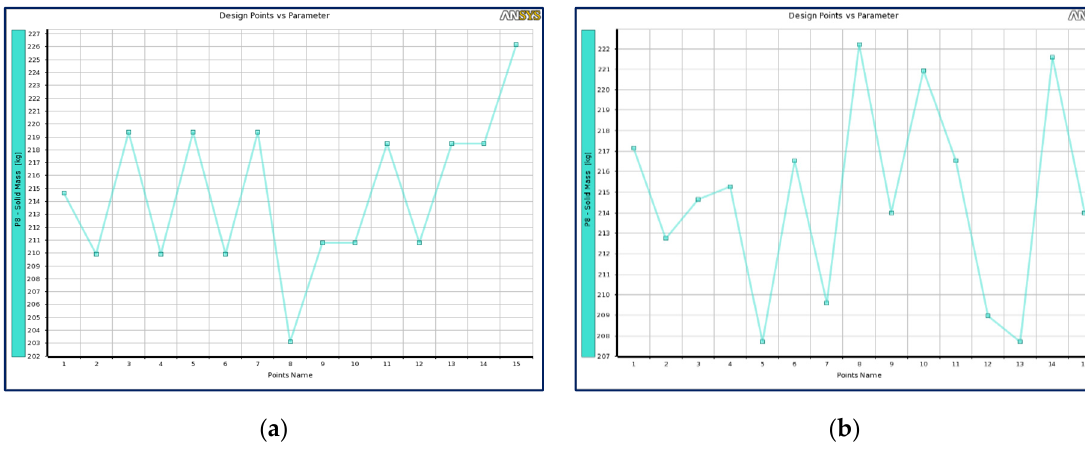
Figure 17. Solid mass vs. design points ( a ) for CCD scheme ( b ) for optimal space filling design.